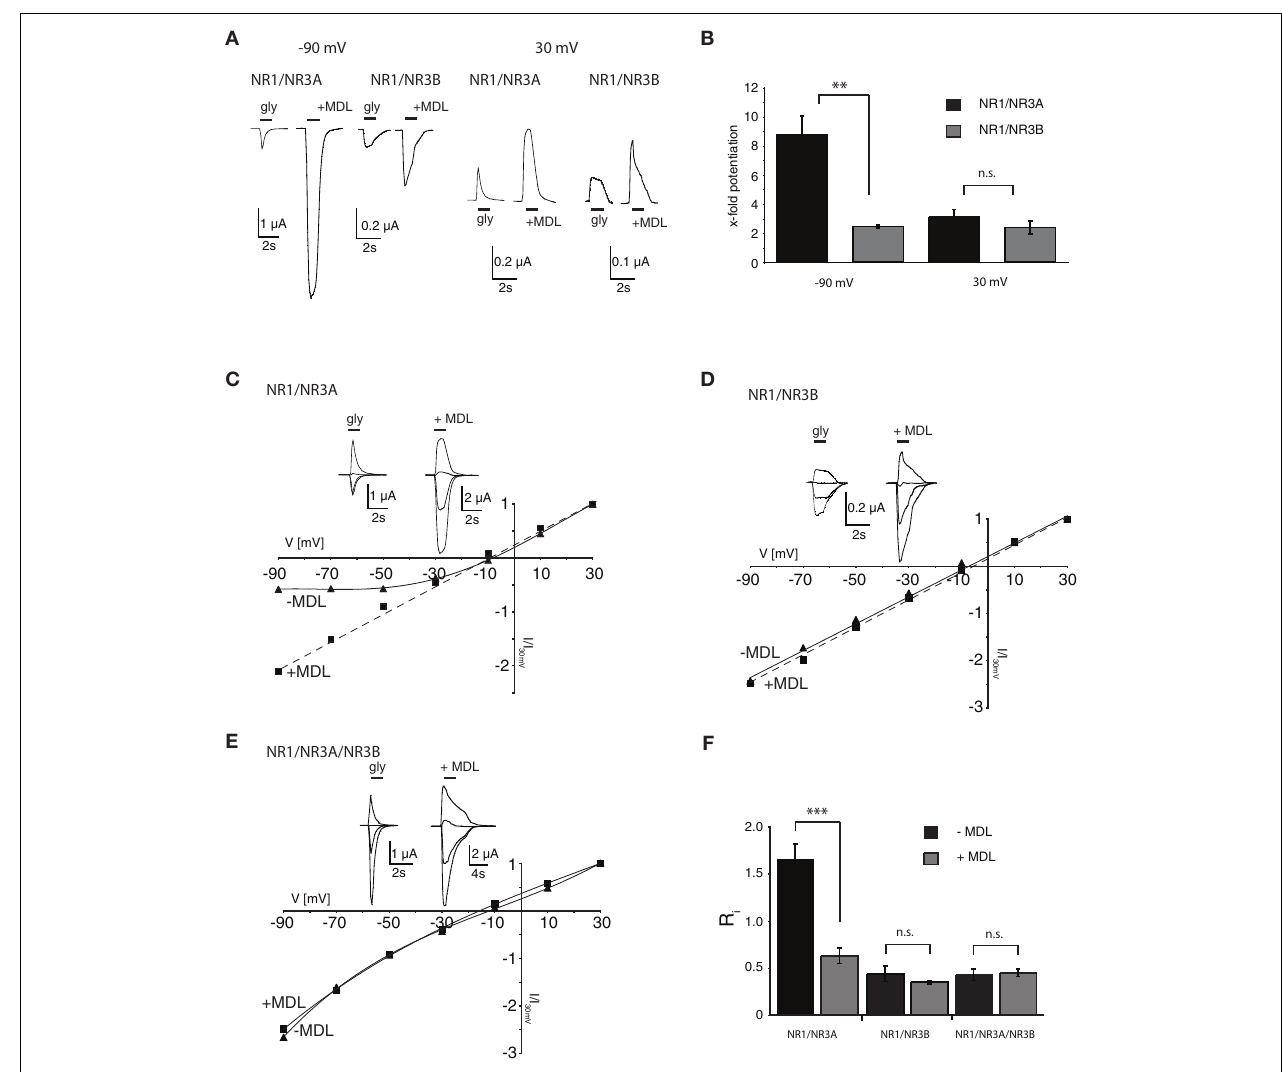
FIGURE 1 | I–V relationships of glycine-gated NR1/NR3 receptors. (A,B) Effect of holding-potential on MDL-29951 (MDL) potentiated glycine currents of NR1/NR3A and NR1/NR3B receptors. (A) Sample traces at − 90mV (left) and + 30 mV (right) activated with a saturating glycine concentration (1 mM) in the absence or presence of 200 nM MDL. (B) Relative potentiation by MDL of NR1/NR3A (black bars) and NR1/NR3B (gray bars) receptor currents at − 90 and + 30 mV. Note that MDL-potentiation was at − 90 mV about 3-fold larger for NR1/NR3A receptors compared to NR1/NR3B ( p < 0.01; n = 5). (C–E) Normalized I–V plots of NR1/NR3A (C) , NR1/NR3B (D) and